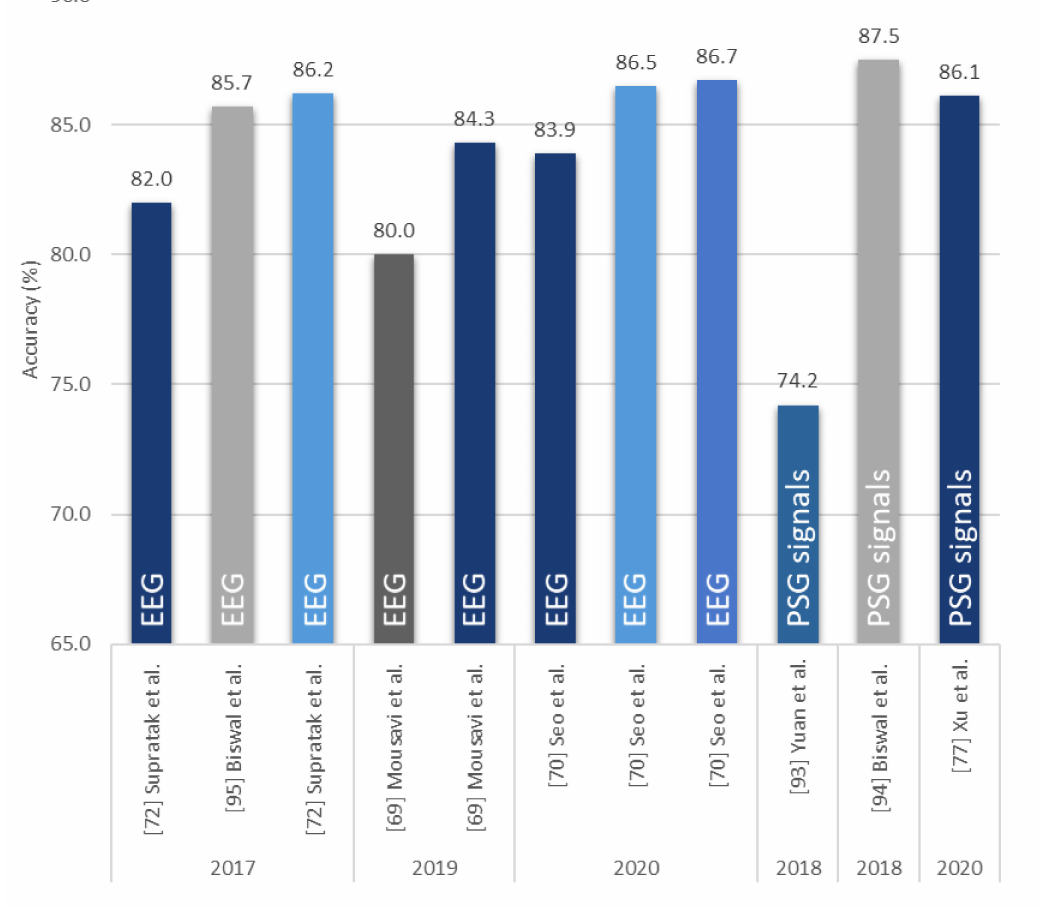
Figure 13. Performance of proposed hybrid models using EEG signals or a mixture of signals. Various sleep datasets are represented by di ff erent colors and the type of signals are described in the bar chart. * Summary statistics: di ff erent datasets used to build hybrid models using EEG / PSG